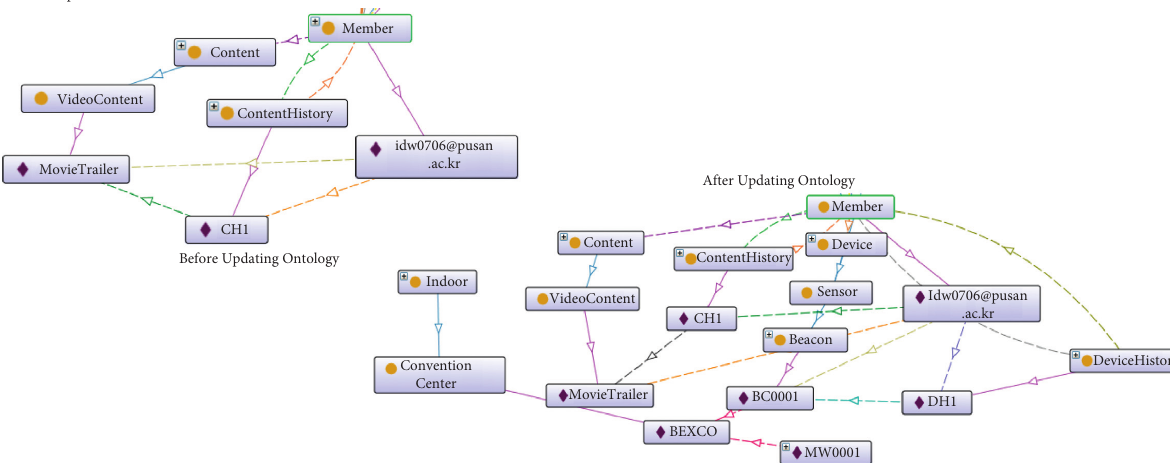
Figure 7: Ontology for content recommendation.